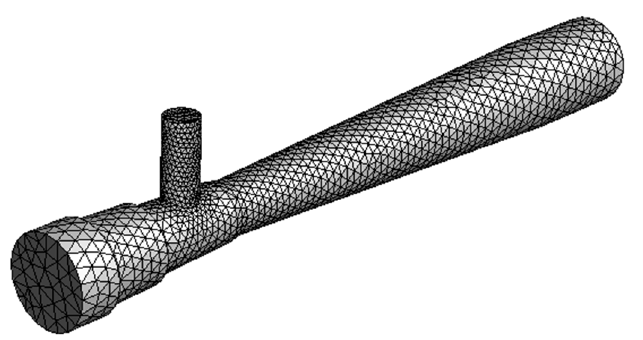
Figure 10. Grid structure of the Venturi injector.